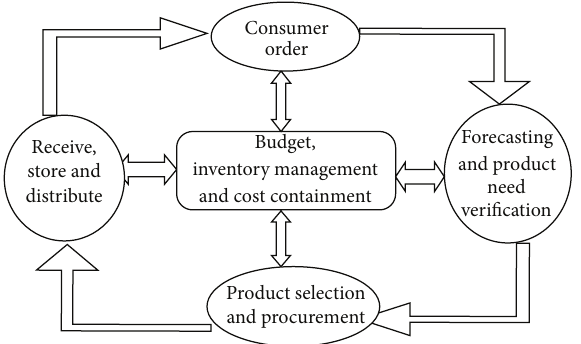
Figure 1: Modern Healthcare SCM